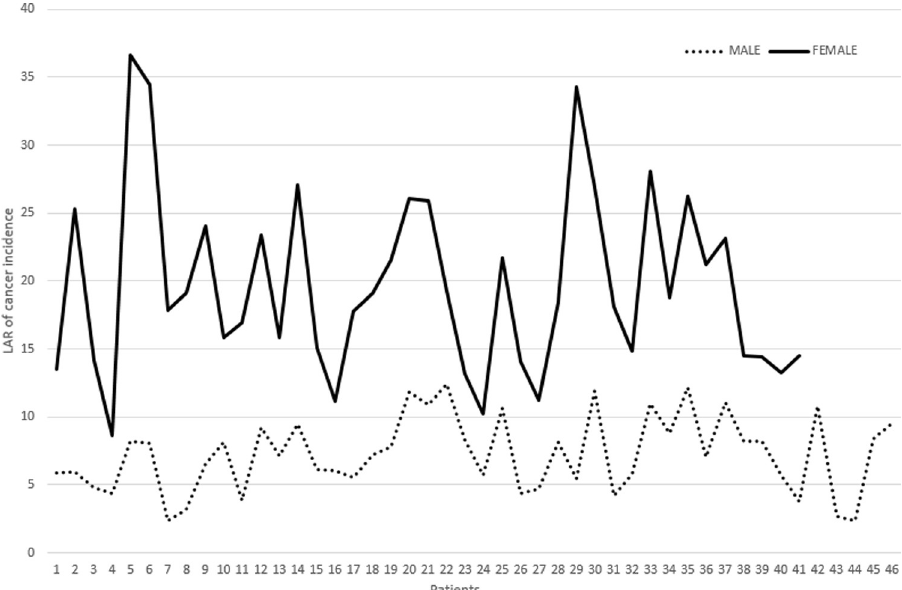
2. plots the cumulative lung cancer LAR for males and females subjected to sequential CTCA and CTCS scans. The estimated lung cancer risks were noticeably lower in males than in females, being 1 in 8000 for a 50-year-old man, equivalent to the risk to an 80-year-old woman. It has also been demonstrated that the risks to lung cancer in men decreases as a function of age, 1 in 9000 for a 60-year-old man, 1 in 18,000 for a 70-year-old man and 1 in 43,000 for an 80-year-old man per 100,000 patients.